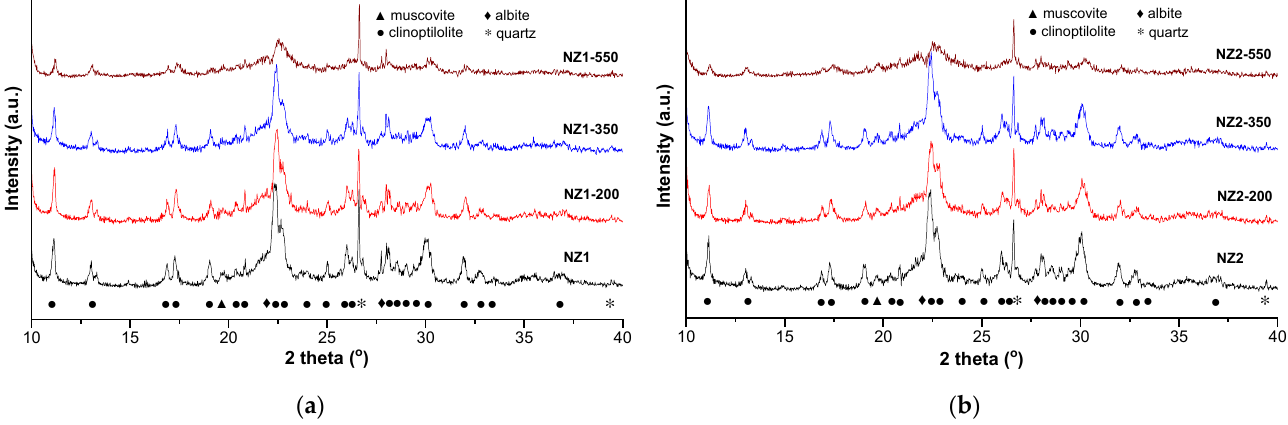
Figure 1. X-ray diffraction patterns of the initial and zeolitic tuff thermally treated at 200 °C, 350 °C, and 550 °C: ( a ) NZ1 and ( b ) NZ2.